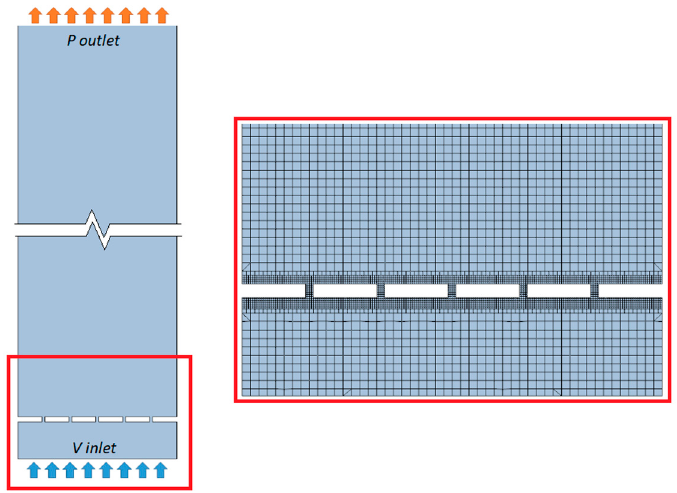
Figure 6. Computational domain. Mesh and cell refinement around grid.